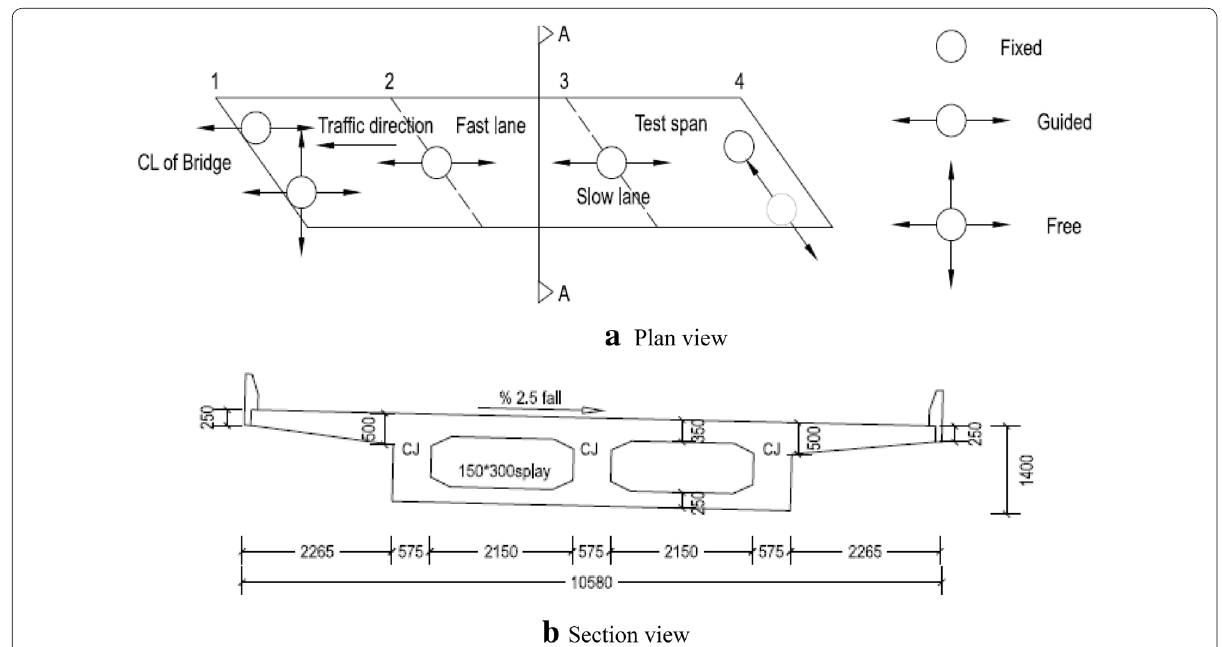
Fig. 3 Bridge configuration and boundary